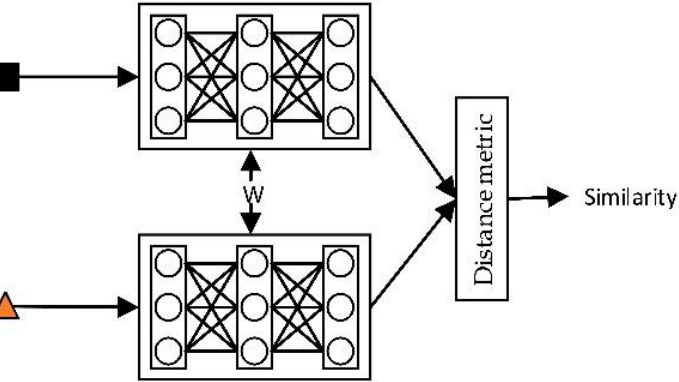
Figure 8. An example of deep metric learning [117] .